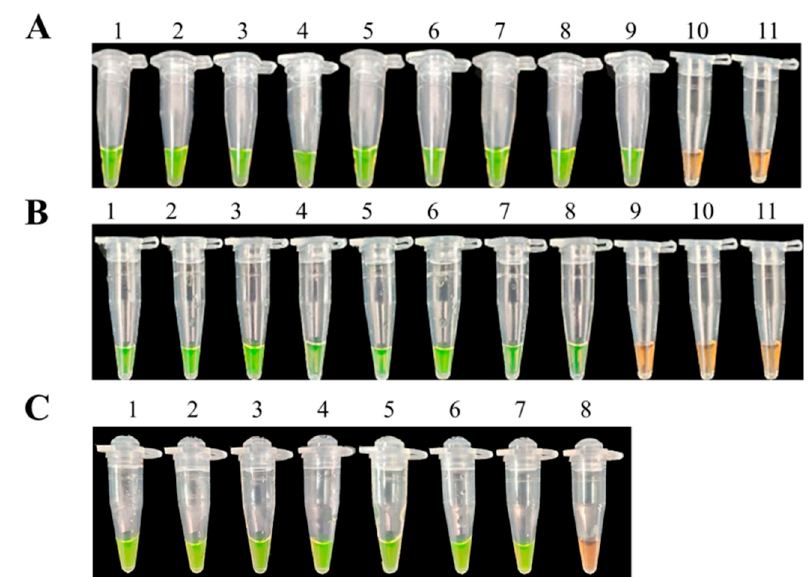
Figure 7. The feasibility detection of the LAMP assay. LAMP reactions were inspected by adding SYBR Green I dye. ( A ) = LAMP detection of F. oxysporum from tissues after infection: 1, purified genomic DNA of F. oxysporum (positive control); 2–10, DNA from D. officinale stems infected by F. oxysporum ; 11, DNA from healthy D. officinale stems (negative control); ( B ) = LAMP detection of F. oxysporum from soil after infection: 1, purified genomic DNA of F. oxysporum (positive control); 2– 10, DNA extracted from soil after infection; 11, DNA from sterilized soil (negative control); ( C ) = LAMP detection of field issues: 1, purified genomic DNA of F. oxysporum (positive control); 2–7, DNA extracted from field issues; 8, DNA from healthy D. officinale stems (negative control).